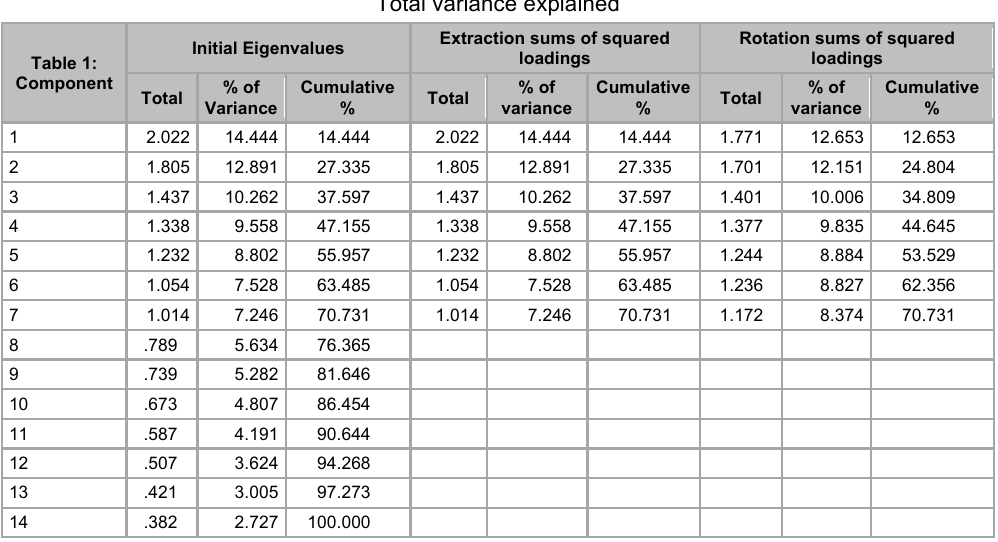
Total variance explained Extraction sums of squared